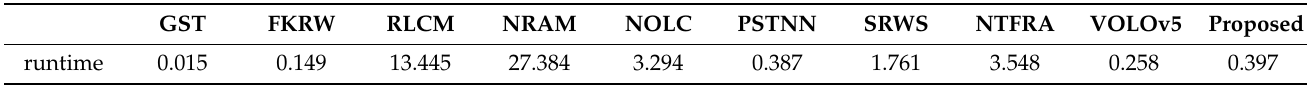
Table 9. Comparison of average runtime between the proposed method and 8 baseline methods in 14 sequence